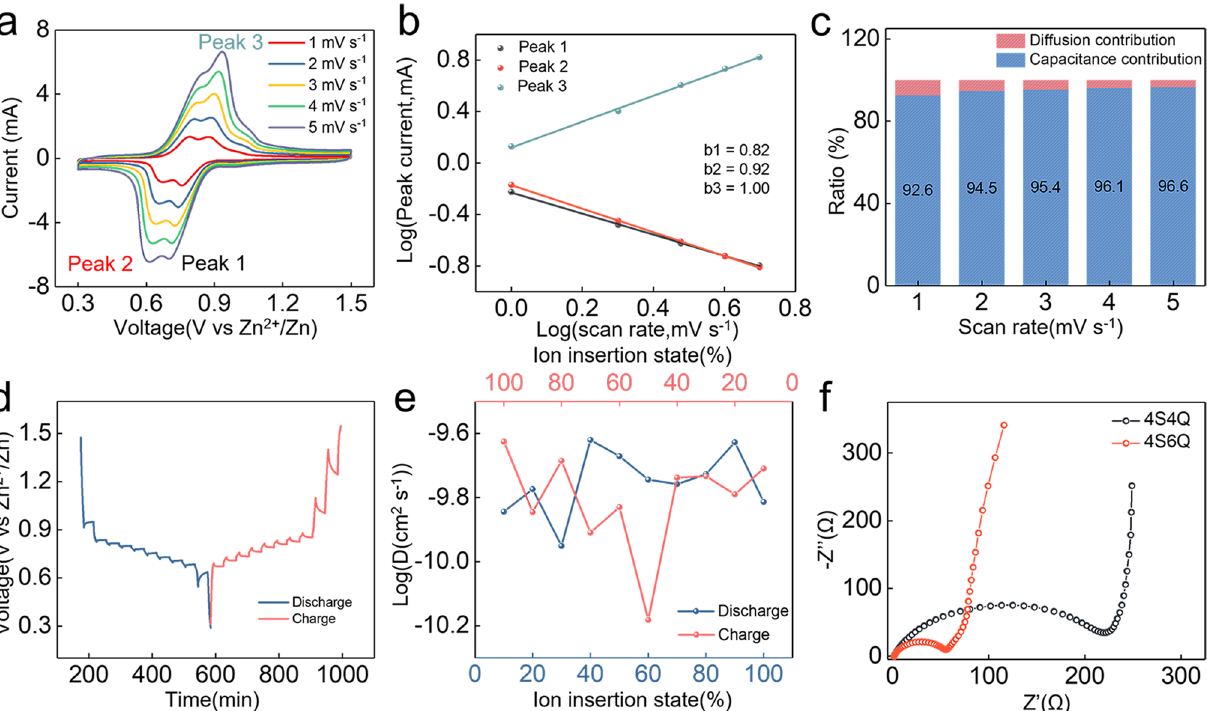
Fig. 4 The studies of reaction kinetics. a CV curves of Zn//4S6Q battery at different scan rates. b The calculated b values for different peaks. c Calculated capacitance/contribution ratios at different scan rates. d Charge–discharge curves of Zn//4S6Q battery for GITT test. e Calculated D ions by GITT test, f the EIS of 4S4Q and